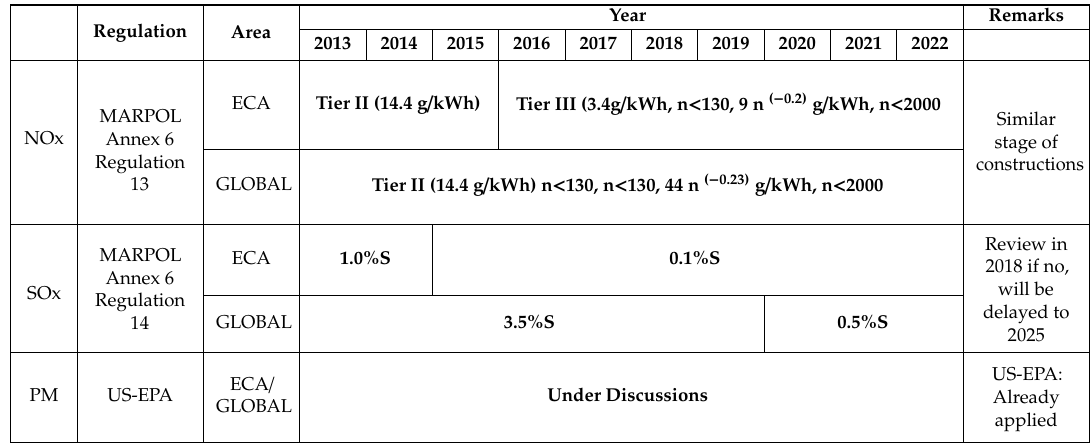
Table 1. International Maritime Organization (IMO) Tier III regulation